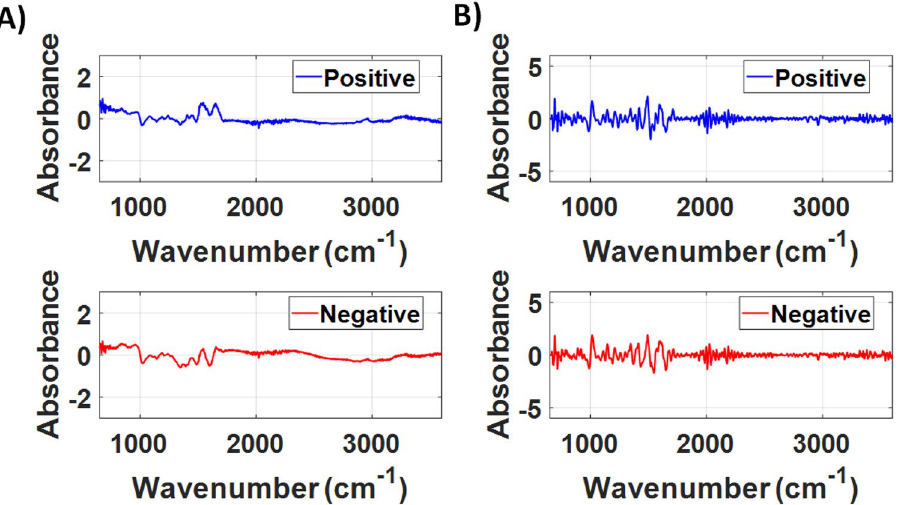
Figure 6. ( A ) Averaged FTIR spectra and ( B ) averaged second derivative of the FTIR spectra ( B ) of the COVID-19 positive and negative groups of the LIQUID 2